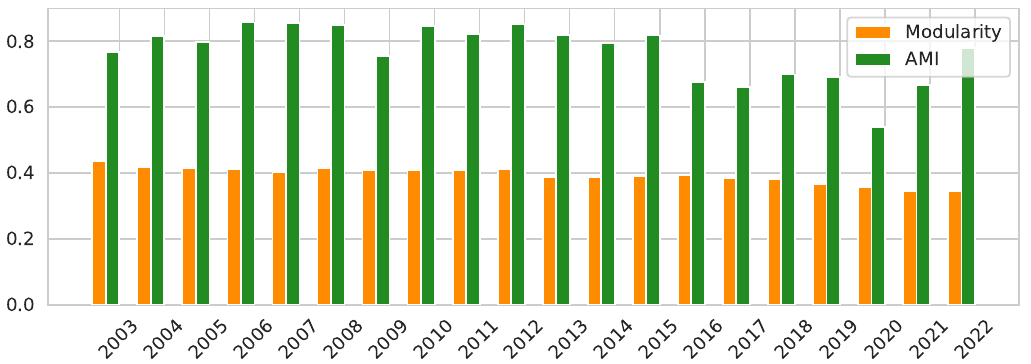
Figure 6. Self-similar evolution of the technology-convergence network. ( a ) The complementary cumulative distributions of d res . ( b ) The clustering coefficients over the rescaled degree C ( d res ) . ( c ) The normalized average degree of neighbors over the rescaled degree d corresponds to a different year. The curve overlaps demonstrate that the topological properties remain stable over time, which reflects the self-similarity characteristic of the growth process.